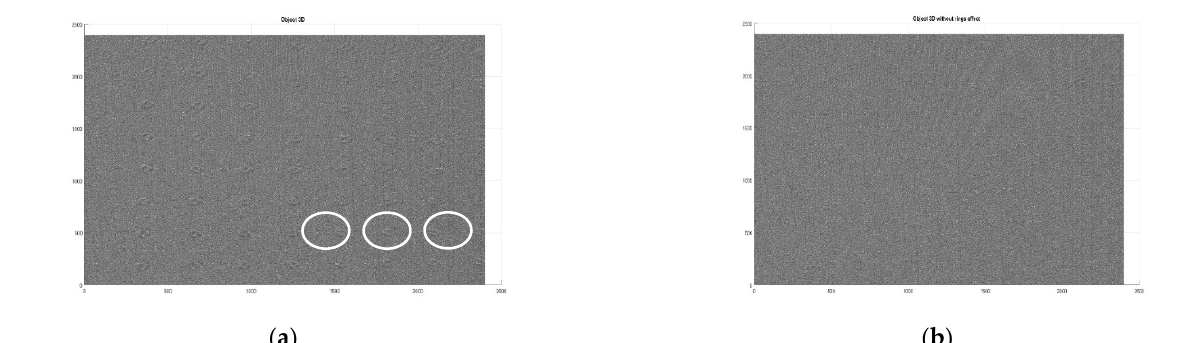
Figure 7. The procedure of transverse calibration.